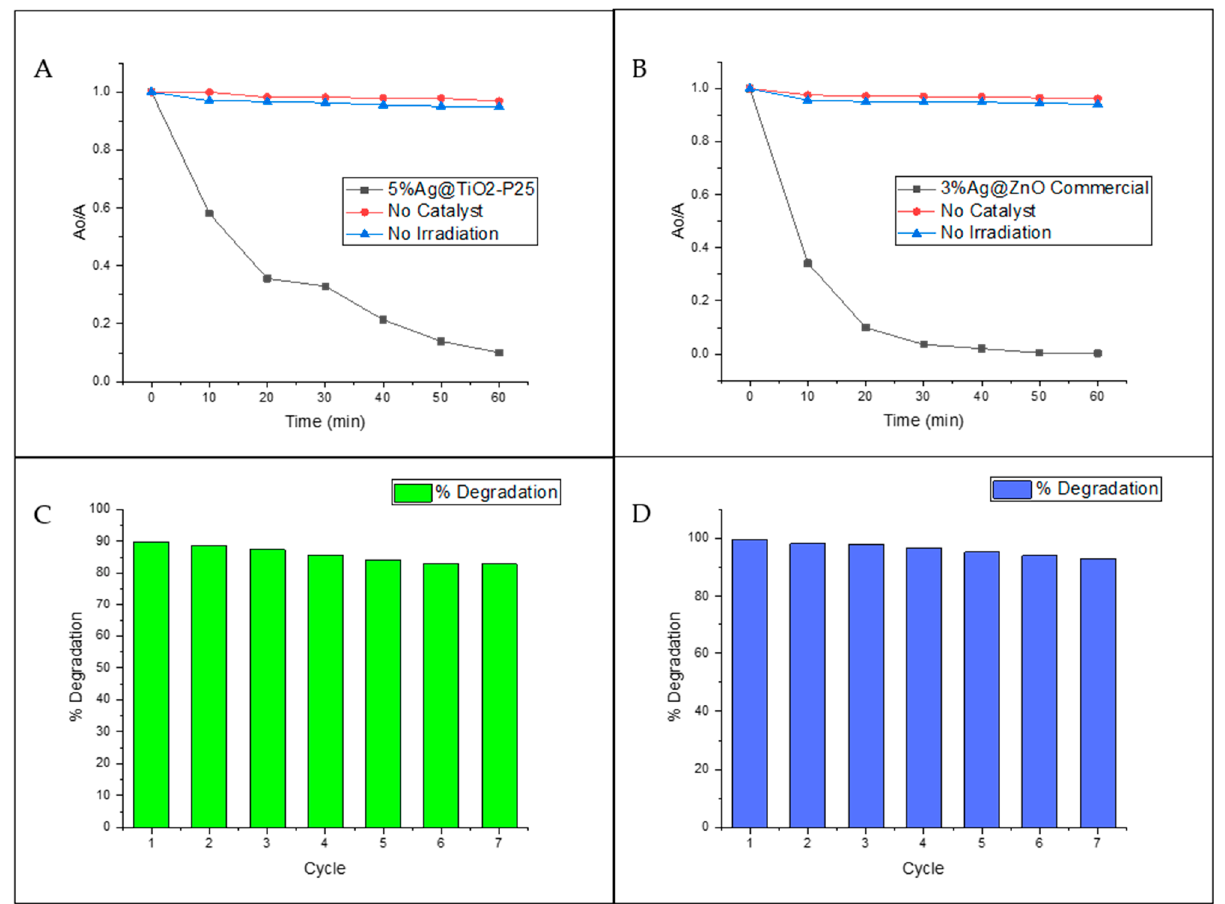
Figure 9. Control experiments and stability tests for the 5%Ag@TiO 2 -P25 ( A , C ) and 3%Ag@ZnO commercial ( B , D ) catalysts.